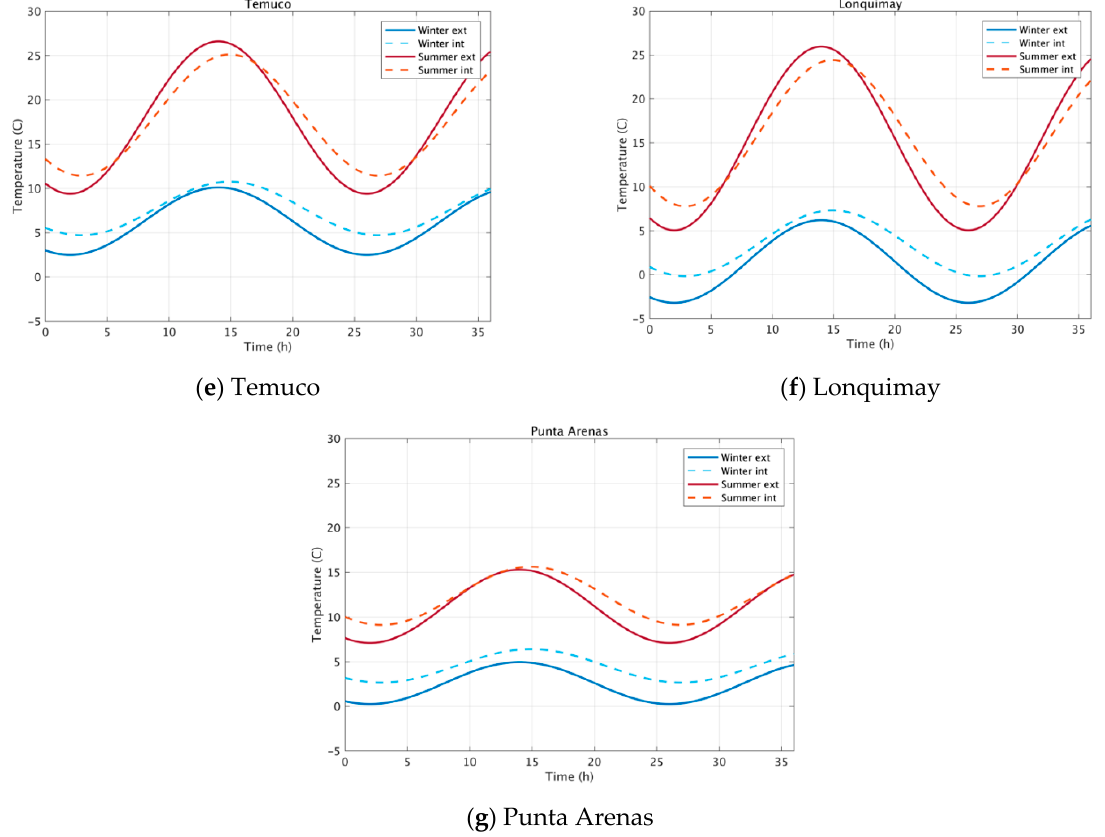
Figure 5. Thermal oscillation of m50 solution, in winter and summer, for representative cities of the seven climate zones of Chile.